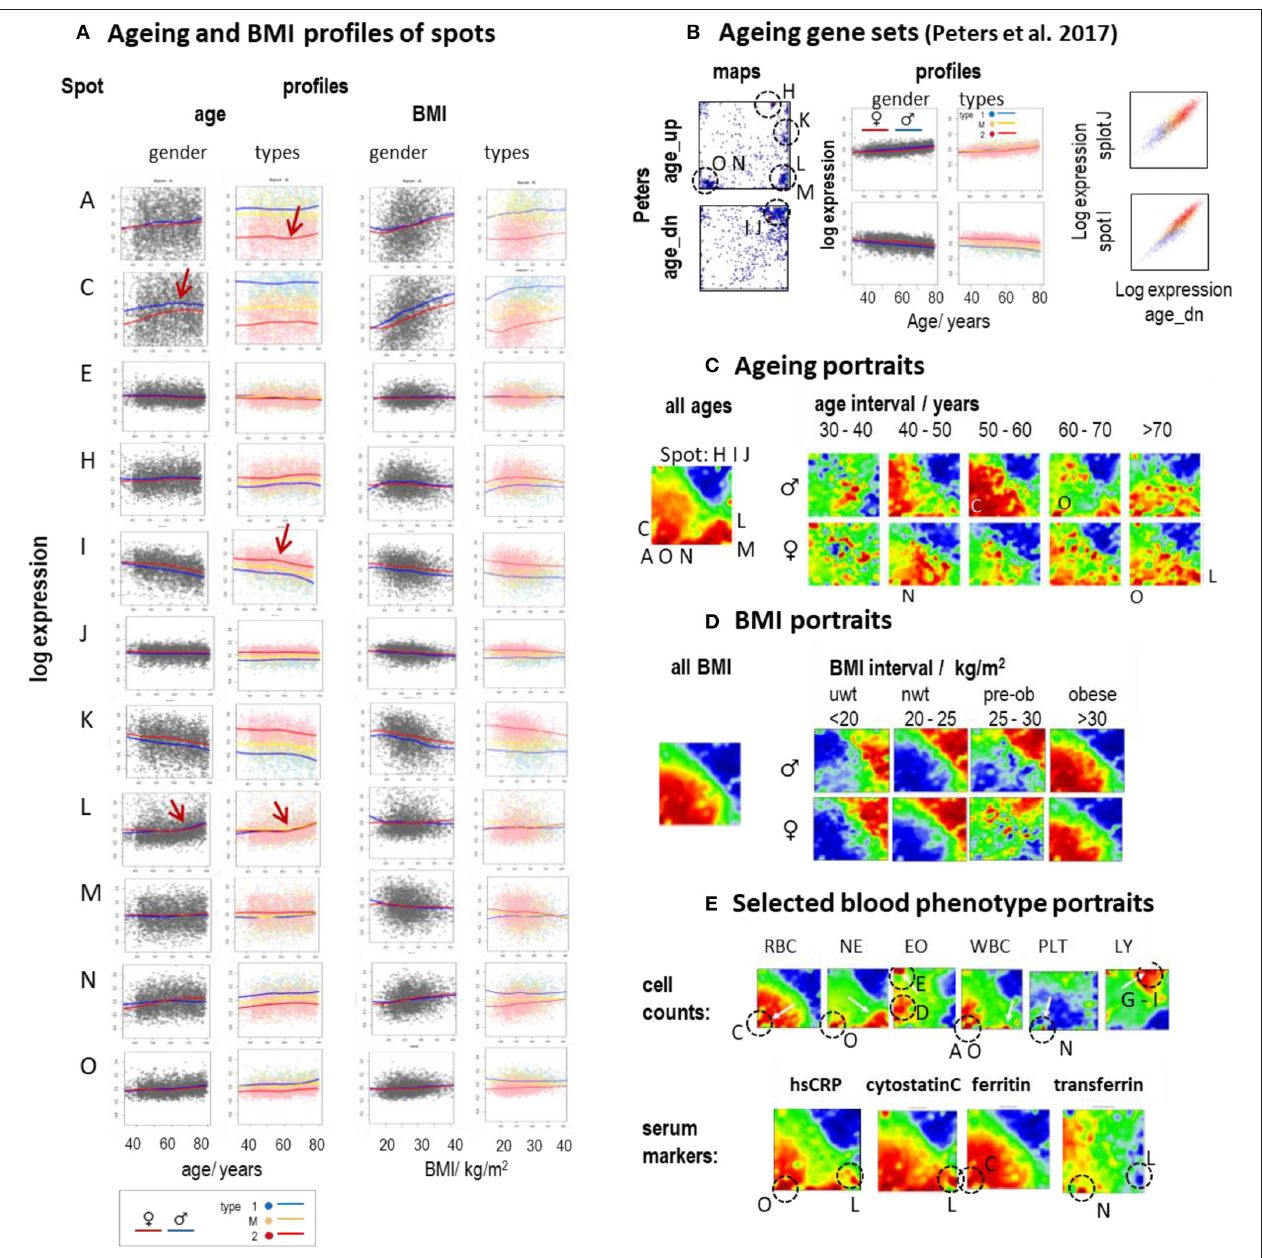
FIGURE 6 | Aging and BMI characteristics of the blood transcriptome: (A) Expression of selected spots as a function of age and BMI. Separate LOESS (local weighted scatterplot smoothing) fits for women and men (red and blue curves) and for types 1, M, and 2 visualize mean spot expressions as a function of age and BMI. The course is mostly non-linear and change slope at different turning points (see arrows). (B) Genes from previous aging sets (Peters et al., 2015) spread either over a heterogeneous (age_up) or a more homogeneous (age_dn) distribution of spots (letters and dashed circles). The latter set correlates with the expression of spots I and J (correlation plots at the right). (C) The overall aging portrait (of correlations between the ages of the participants and the transcriptome “metagene” landscape) roughly can be understood as superposition of (increasing with age in red) RBC- and NE-like fingerprints and (decreasing with age in blue) LY-patterns. Stratification into decade intervals shows that NE-fingerprints apply mainly to elderly people ( > 60 years) while elevation of RBC is relevant mostly for participants younger than 60 years. (D) Portraits of different BMI strata reveal the continuous change from type 2 (under- and normal-weight participants) to type 1 (obese) transcriptomes. (E) Selected blood cell count and serum marker portraits reveal fingerprint-like patterns. Characteristic “landmark” spots are indicated by dashed circles and the respective spot letters.